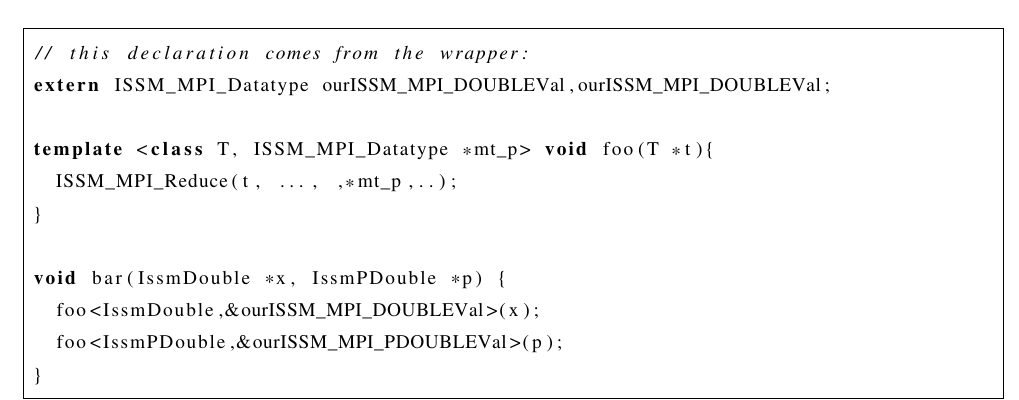
Figure 2. Code snippets for templating with corresponding MPI data